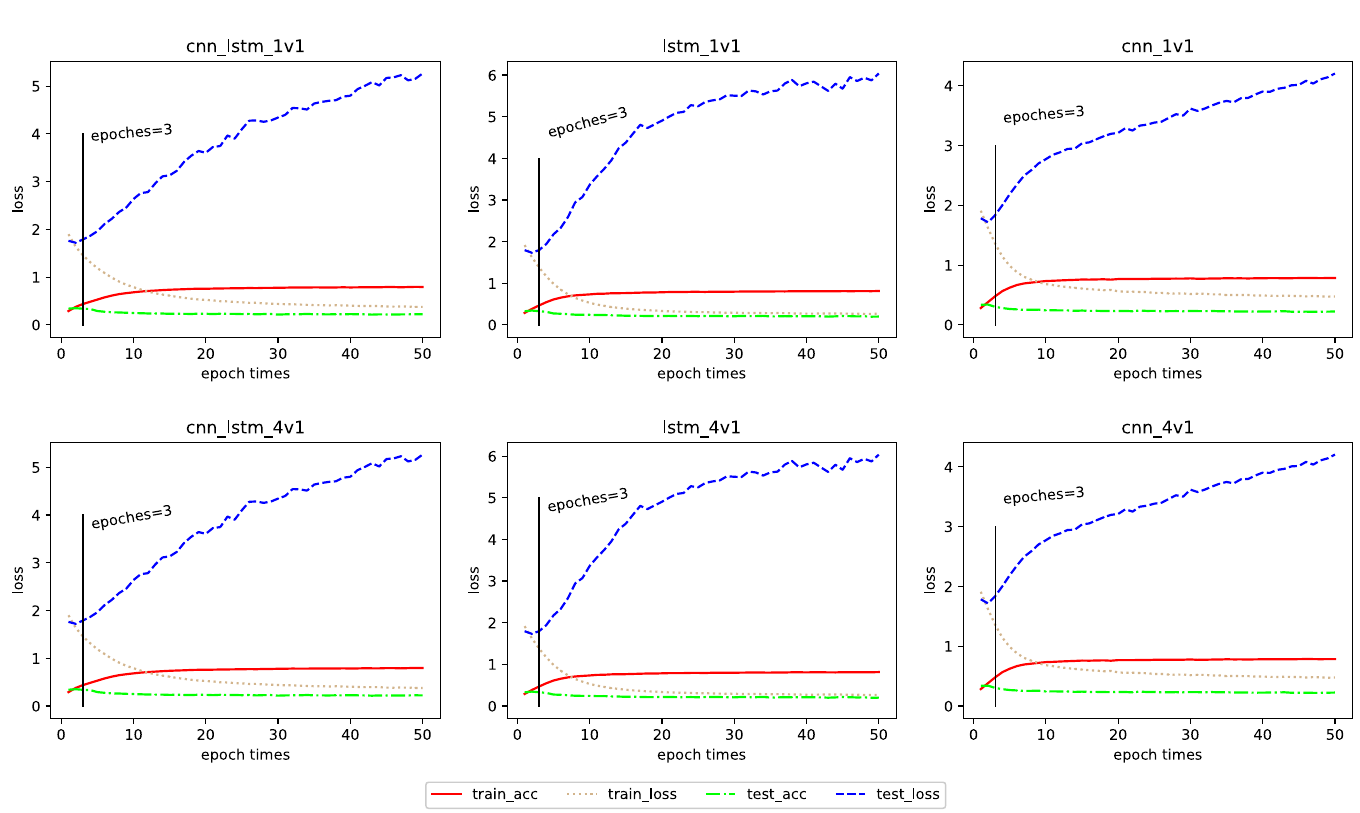
Fig 8. Tendency of accuracy and loss changed with the epochs in three